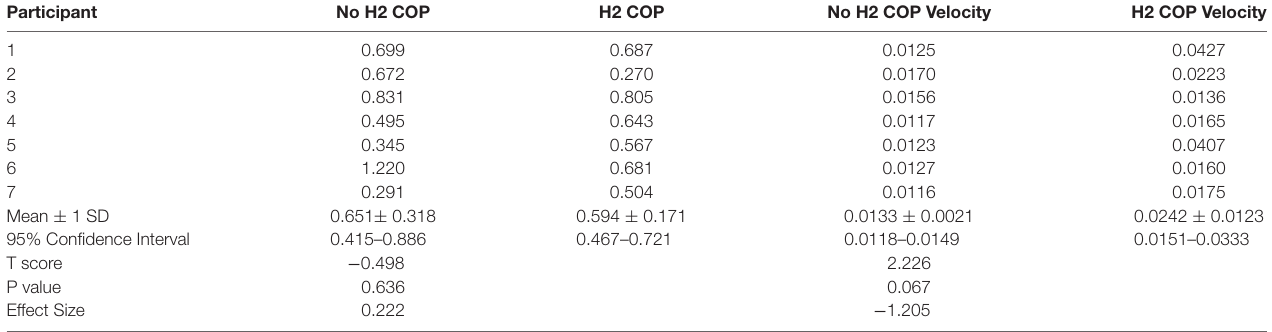
TABLE 1 | COP and COP Velocity RMS values during 2-min quiet stance with and without wearing the H2 exoskeleton.